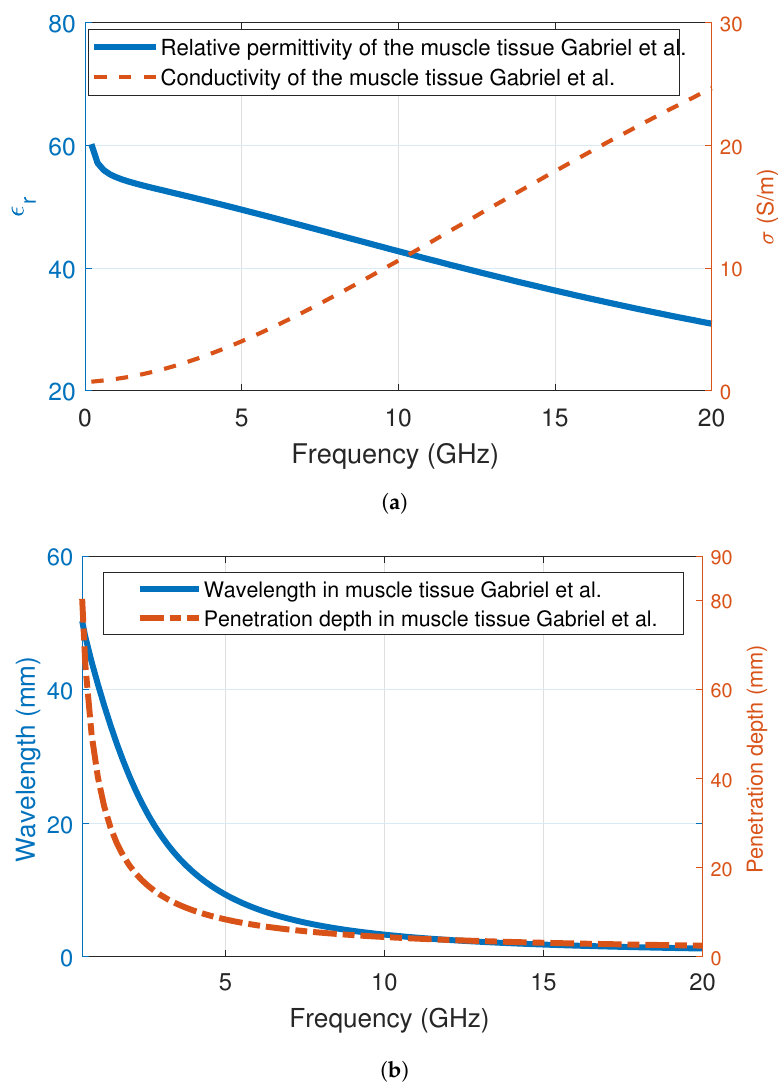
Figure 4. Muscle tissue dielectric properties and wave behaviour in muscle tissue medium: ( a ) relative permittivity and conductivity of muscle tissue between 200 MHz and 20 GHz; ( b ) wavelength and penetration depth in muscle